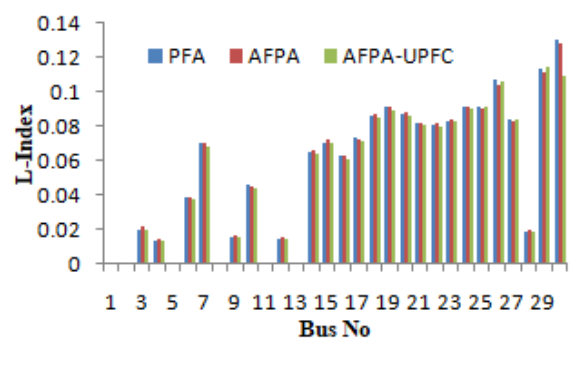
Figure 5. L-indices for different OPF